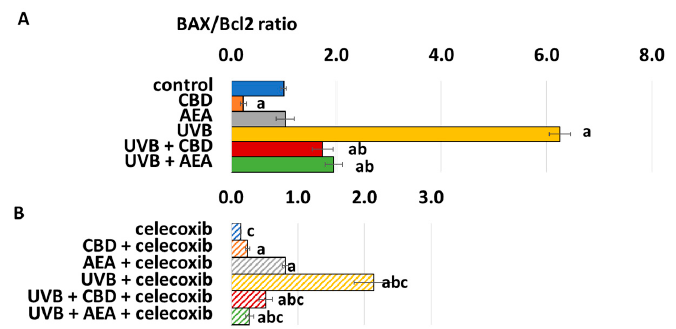
Figure 4. ( A ) BAX/Bcl2 ratio in control keratinocytes treated with CBD (4 μ M) or AEA (4 μ M) or irradiated with UVB (60 mJ/cm 2 ) as well as cells irradiated with UVB and treated with CBD or AEA (in the same concentrations). ( B ) BAX/Bcl2 ratio in keratinocytes after treatment with 20 μ M celecoxib alone and with CBD(4 μ M) or AEA(4 μ M) or irradiated with UVB (60 mJ/cm 2 ) as well as cells irradiated with UVB and treated with CBD or AEA (in the same concentrations). (a)—statisti- cally significant differences between keratinocytes treated with CBD, AEA, UVB, UVB + CBD, AEA + UVB and non-treated cells as well as keratinocytes treated with CBD + celecoxib, AEA + celecoxib, UVB + celecoxib, UVB + CBD + celecoxib and AEA + UVB+ celecoxib and cells treated only with celecoxib; p < 0.05; (b)—statistically significant differences between keratinocytes treated with UVB + CBD, UVB + AEA, UVB + CBD + celecoxib, AEA + UVB + celecoxib and irradiated with UVB p < 0.05; (c)—statistically significant differences between keratinocytes treated with celecoxib and cor- responding keratinocytes not treated with celecoxib. The action of cannabinoids is dependent on their interaction with receptors, the ex- pression of which was increased by UVB. Anti-apoptotic and anti-inflammatory CB2 was about three-fold and pro-apoptotic and pro-inflammatory CB1 about five-fold higher than in the control. This suggests that pro-inflammatory signaling dominates in this case, which may partly explain the pro-inflammatory properties of UVB (Figure 5). Addition- ally, AEA tended to reduce the activation of cannabinoid receptors in untreated keratino- cytes, while in UVB irradiated cells AEA acted the opposite way. On the other hand, can- nabidiol increased anti-inflammatory CB2 expression, but decreased pro-inflammatory CB1.